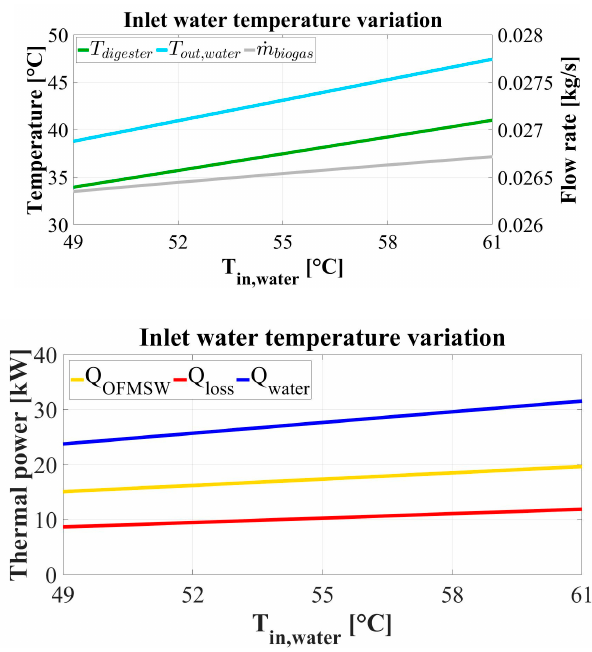
. . . Q & , Q & , Q & (below) vs. Q OFMSW , Q loss , Q water (below) vs. OFMSW loss water